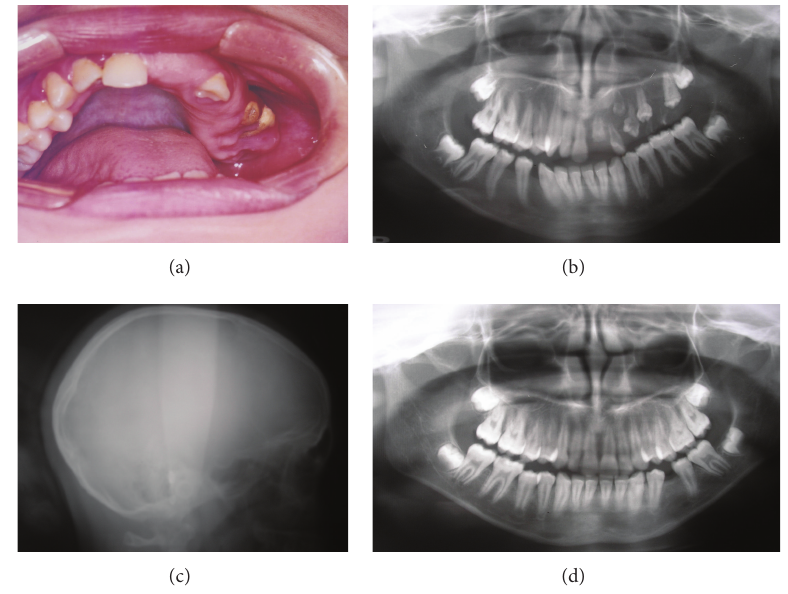
Figure 3: (a) Case 2. Oral condition of ROD of the upper-left quadrant at time of presentation. (b) Panoramic view of Case 2 showing multiple impacted teeth in the upper left quadrant and a missing lower right first premolar. (c) Lateral cephalometric view depicting dolichocephaly. (d) Panoramic view of Case 2 twin brother showing a missing lower left first premolar.